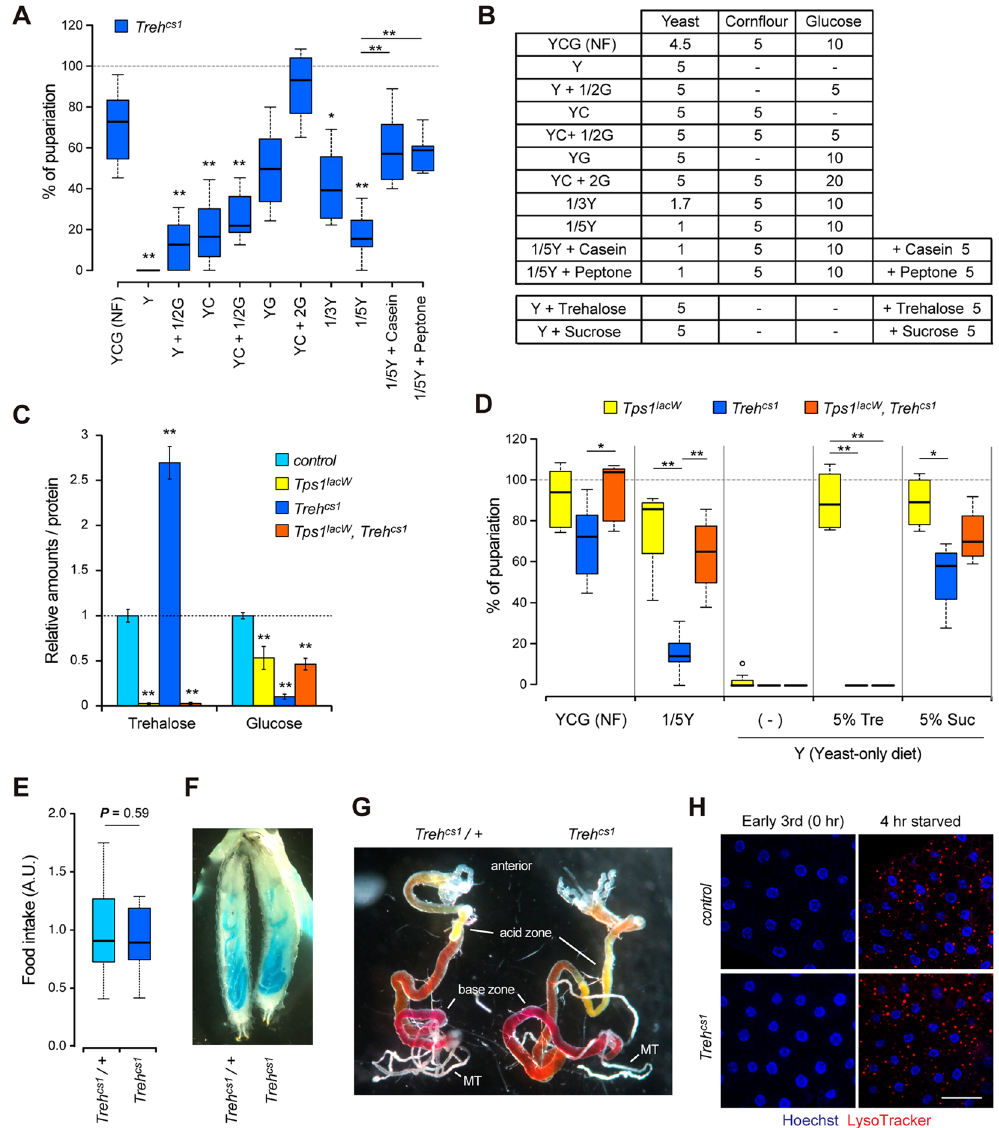
Figure 4. Impact of dietary conditions on the survival of Treh mutant larvae. ( A ) Treh mutants are sensitive to low-glucose and low-protein dietary conditions. Percentages of homozygous mutant pupae were determined by the ratio to heterozygous mutants in each vial. ( B ) Food compositions used in ( A and D ). Values are g per 100 ml. ( C ) The amounts of trehalose and glucose were analyzed in early-third instar larvae. Each value was normalized by protein levels and further normalized according to the level in the control larvae. Values shown are means and SD. ( D ) The pupariation rate of Tps1 and Treh single mutants and Tps1 , Treh double mutants under various dietary conditions. Overaccumulation of trehalose rather than the loss of Treh causes deleterious effects on the adaptation to poor food conditions. Tre, trehalose; Suc, sucrose. ( E ) Treh mutants exhibit normal feeding behaviour. Food intake levels are evaluated by the rate of blue food ingestion at early third-instar larvae. ( F ) Treh mutants retain the epithelial integrity in the midgut. Leakage of ingested blue food into body cavity was tested. ( G ) Treh mutants have the normal segmented intraluminal pH zones in the midgut. Mid third instar larvae were fed with food containing phenol red dye to detect luminal pH. Phenol red changes from red to yellow at pH < 3 (acid zone) and to dark pink at pH > 10 (base zone). MT, Malpighian tubules. ( H ) Treh mutants exhibit no abnormality of autophagy in the fat body under fed and starved conditions. Dissected fat body at early third instar larvae were stained for LysoTracker (red) and Hoechst (blue) to label nuclei. Scale bar = 50 μ m. n = 6~12 ( A , D ), n = 4 ( C ), or n = 10 ( E ). ** p < 0.01, * p < 0.05; ( A , C , D ) one-way ANOVA with Tukey’s post hoc test, ( E ) two-tailed Student’s t